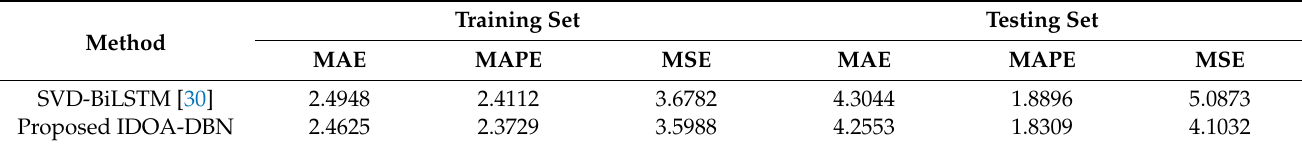
Table 6. Comparative analysis of prediction results in training and testing set.